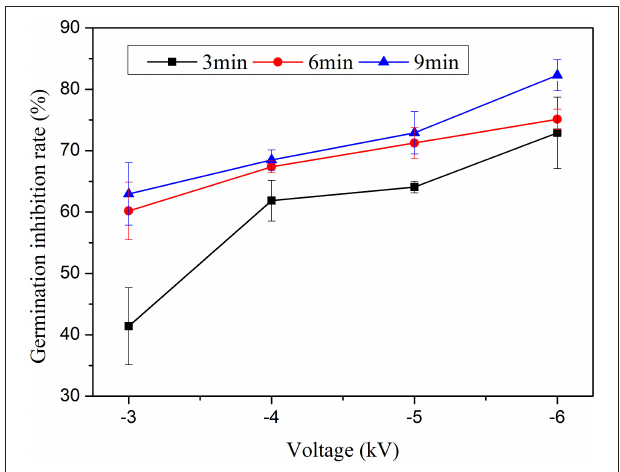
FIGURE 4 | Changes in the germination inhibition efficiency with the response time when the treatment time is 6min, the storage time is 5min, and the water content is 9.57mg L − 1 .